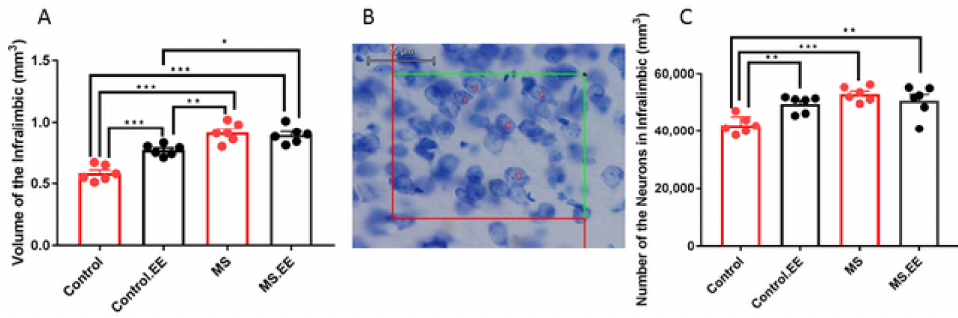
Figure 6. Effects of maternal separation and EE on the ( A ) volume of infralimbic area. ( B ) Illustration of counting the number of neurons in the infra-limbic area with optical fractionator method using objective lens 60 × ( C ) Changes in the number of pyramidal neurons in the infra-limbic area of mPFC following MS and EE. * p < 0.05, ** p < 0.01, *** p < 0.001. N = 6 in each group. MS: Maternal Separation, EE: Environmental Enrichment.